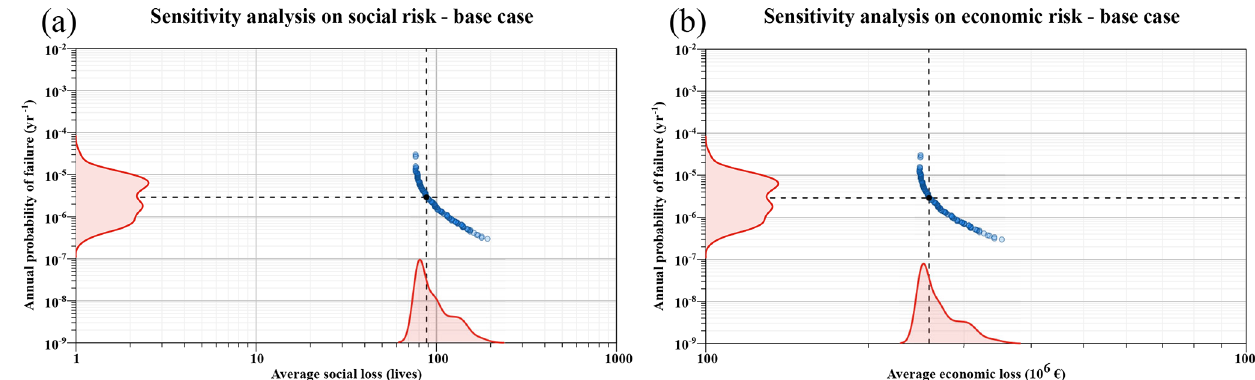
Figure A2. Effect of precipitation sampling uncertainty on (a) social risk and (b) economic risk. The kernel density plot for each variable is displayed in red on the x and y axes. The base case situation is highlighted with a black point and two dashed